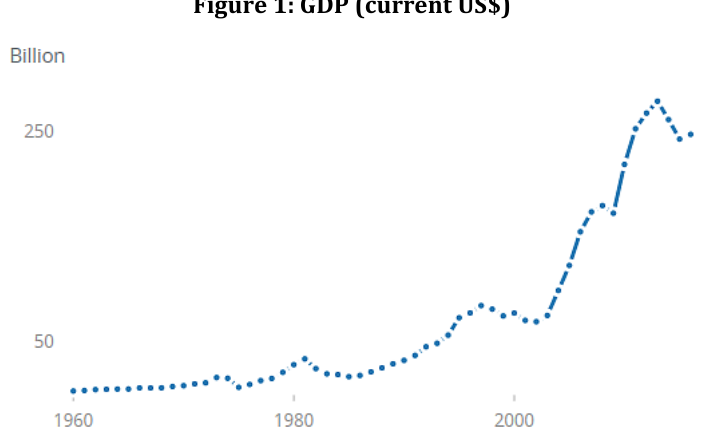
Figure 1: GDP (current